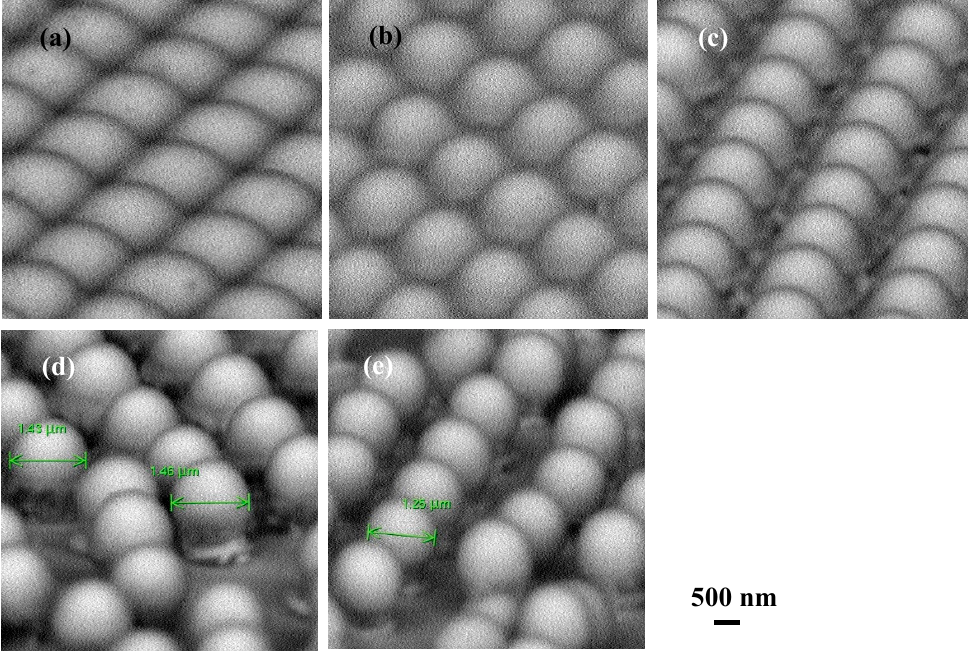
Figure 2. An oblique view of the SEM images of the aligned silica glass microspheres on silicone rubber after the HF chemical etching for ( a ) 0, ( b ) 15, ( c ) 30, ( d ) 60, and ( e ) 90 s.